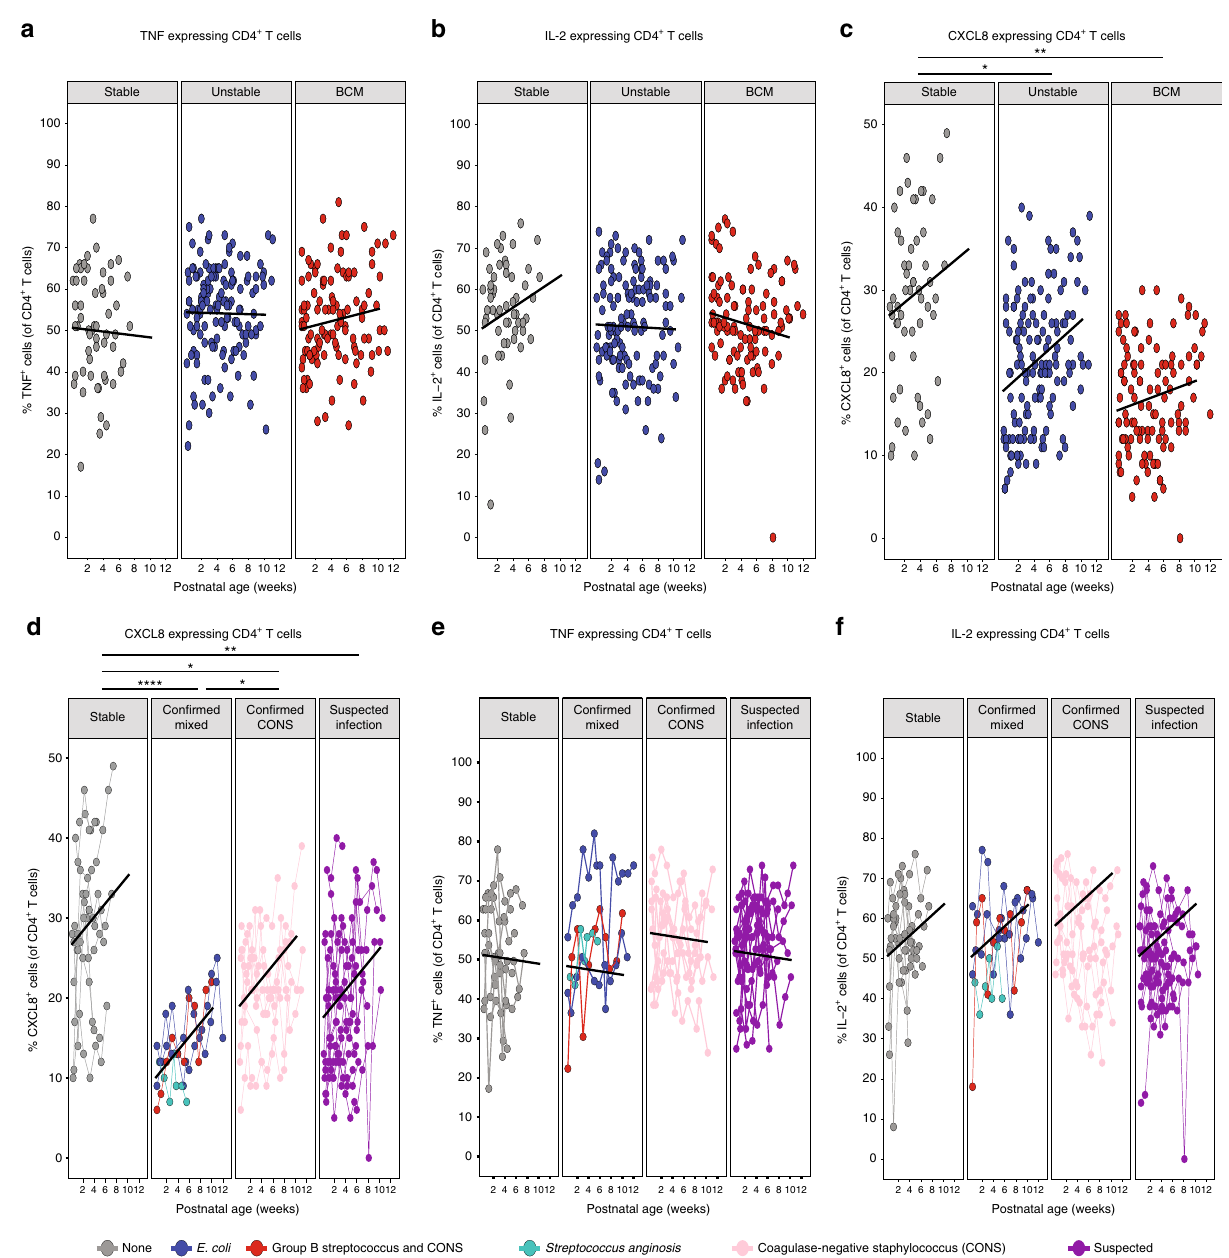
Fig. 6 Unstable infants have signi fi cantly reduced CXCL8-producing T cells compared to stable babies. Longitudinal PBMC samples from 39 preterm babies were activated in vitro with PI (4 h, in the presence of BFA) and expression of CXCL8, TNF and IL-2 assessed by fl ow cytometry. Scatter plots showing frequencies of a TNF, b IL-2 and c CXCL8 in stable babies (left panel; grey circles, n = 10), unstable babies (middle panel; blue circles, n = 16) and BCM babies (right panel; red circles, n = 13) as a function of postnatal age. In a – c , data shown are a pool of longitudinal samples from each clinical group where each circle represents a longitudinal sample from an individual baby and on average there are six samples per baby in the stable cohort and nine samples per baby in the unstable cohort and the BCM cohort. Blood culture-positive bacteraemias were separated into those from coagulase-negative staphylococci (CoNS) and other bacteria as CoNS infections are generally considered to be less severe with lower mortality rates. Scatter plots showing the frequencies of d CXCL8, e TNF and f IL-2 in stable babies (far left panel; grey circles, n = 10 babies with a mean of eight longitudinal samples per baby), babies with microbiologically con fi rmed infections (second panel; n = 4 with a mean of 11 longitudinal samples per baby), babies with coagulase-negative staphylococcal infections (CoNS) (third panel, n = 9 with a mean of 10 longitudinal samples per baby) and babies with suspected infections (far right panel; n = 16 with mean of seven longitudinal samples per baby). The colour of the circles depicts the type of infection as described in the fi gure. In d – f , each circle represents a longitudinal sample from an individual baby and linked circles represent longitudinal samples from the same baby. *** p < 0.001, ** p < 0.01 and * p < 0.05 as determined by linear mixed-effect modelling using the lmer package in R. Source data are provided as a Source Data fi